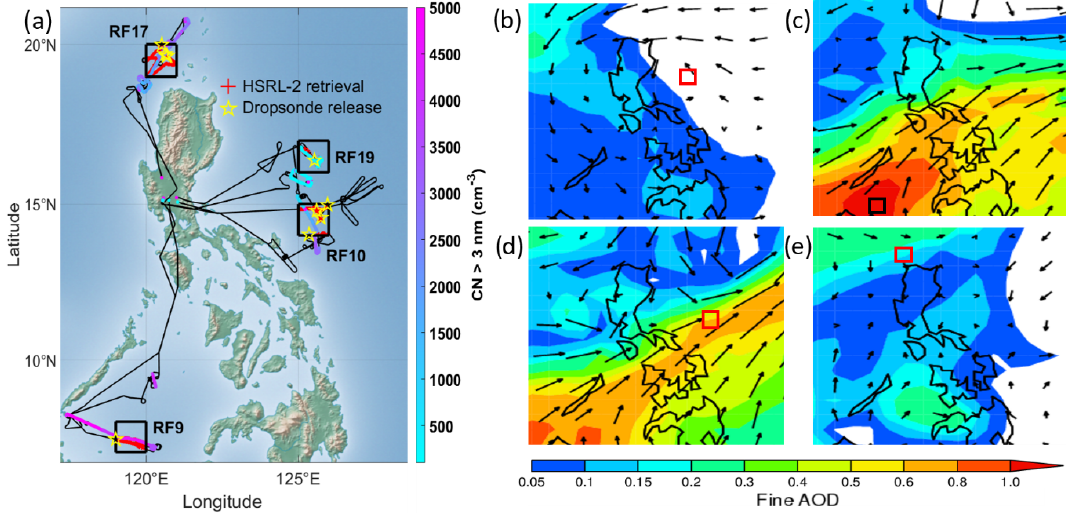
Figure 1. Relevant spatial information for the four case studies including (a) flight tracks (black lines), grid cells selected to represent each case study (black squares), and locations where HSRL-2 retrievals were available (red crosses) and dropsondes were released (yellow stars) within the selected grid cells. Flight tracks are colored by particle number concentrations (i.e., condensation nuclei (CN)) observed at altitudes within the ML. Simulations of NAAPS-RA fine aerosol optical depth (AOD) and 925mbar wind speed are shown for the 6h periods most relevant to (b) Case I on 5 October 2019 (RF19), (c) Case II on 15 September 2019 (RF9), (d) Case III on 16 September 2019 (RF10), and (e) Case IV on 1 October 2019 (RF17). White coloring indicates a fine AOD of ∼ 0. Red squares indicate the 1 ◦ × 1 ◦ grid cell relevant to each case study (a black square is used for Case